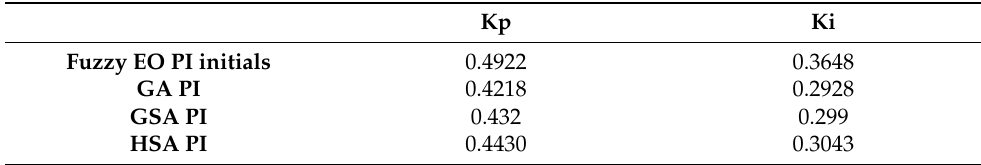
Table 3. Gains of controller in case 1 and 2.